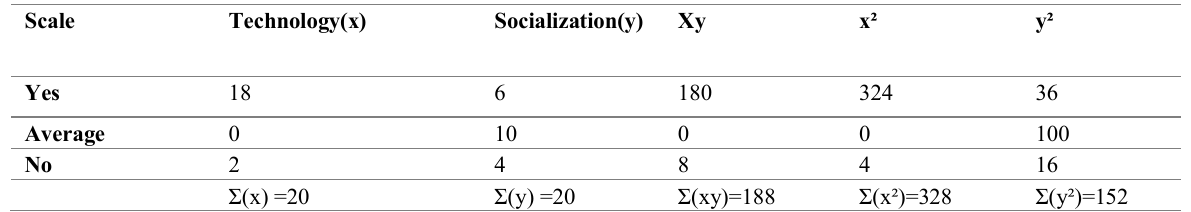
Table 6: An analysis of the relationship between technology and its impact on